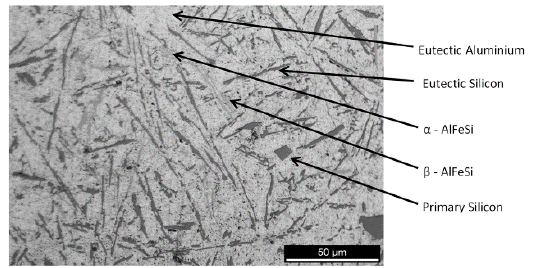
Figure 11. Microstructure of a sample with a wall section diameter of 1mm, poured at a temperature of 635 °C in a mold at 350